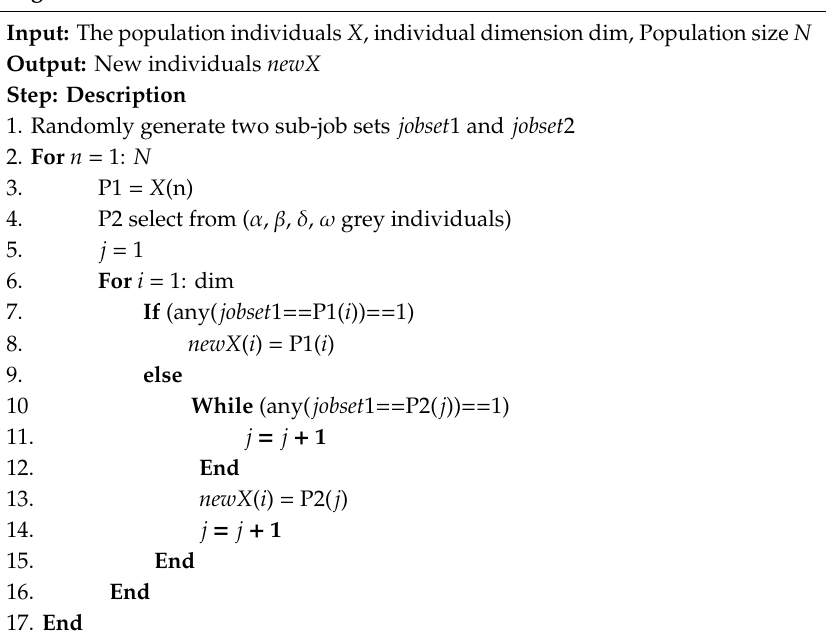
Algorithm 3. LOX